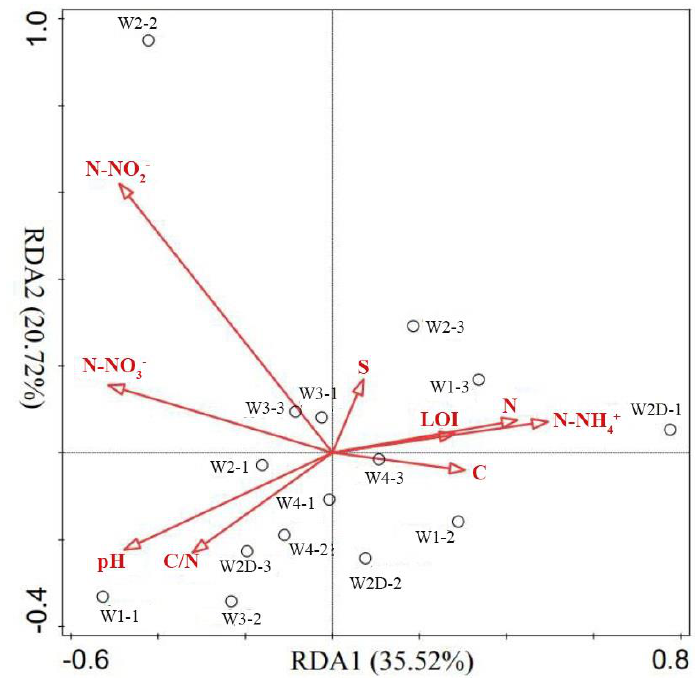
Figure 4. Redundancy analysis of bacterial community and physicochemical properties.